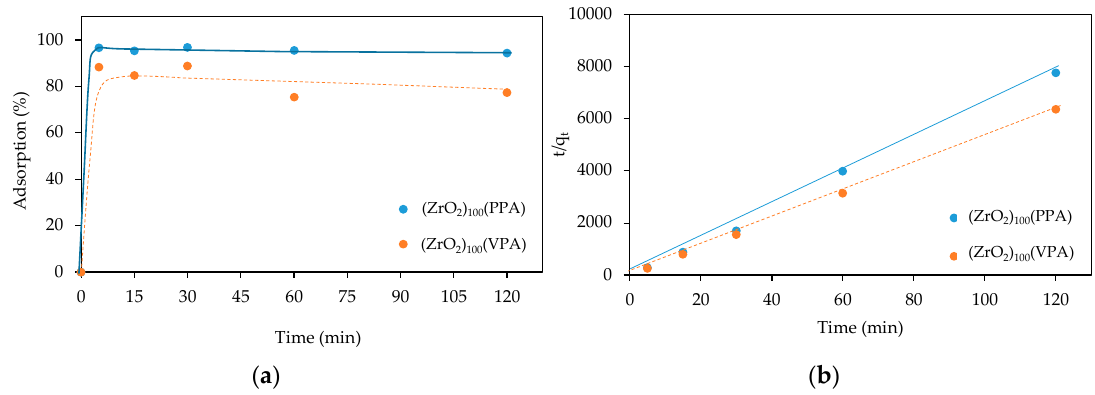
Figure A5. Variation of the surface species content of ZrO 2 as a function of the ratio used, accord- ing to X-Ray Photoelectron Spectroscopy study of (ZrO 2 ) x (PAA) Samples (Zr/P ratio ( x ) = 25, 50, 100, 200).